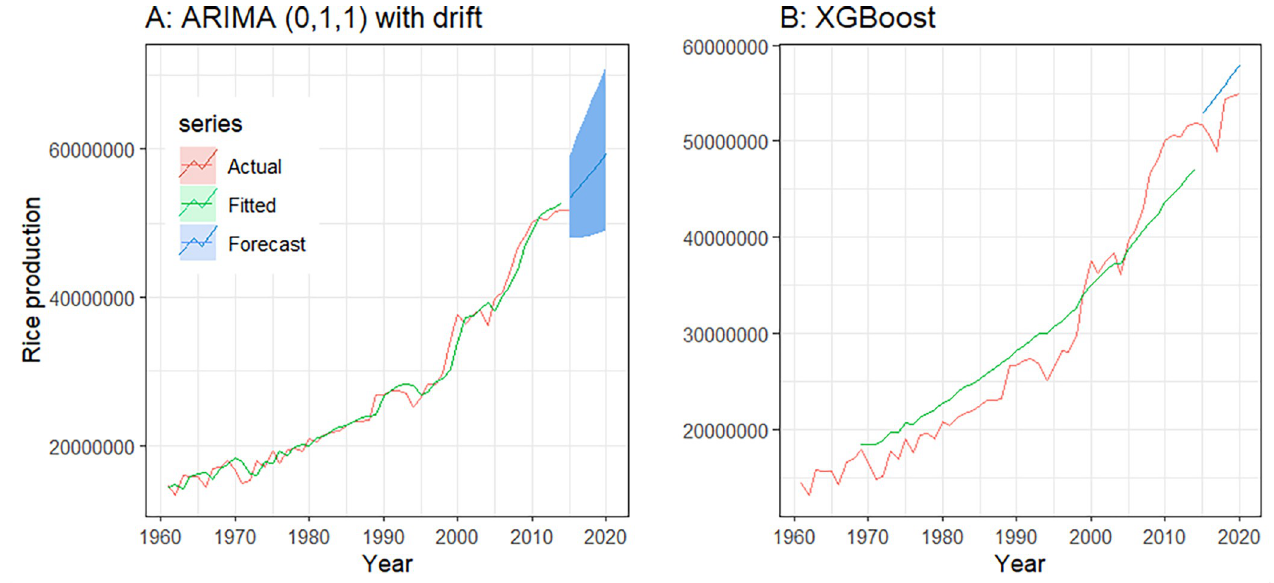
Fig 9. ARIMA and XGBoost model show the actual, fitted and forecasted data for rice production in Bangladesh. ARIMA, autoregressive integrated moving average; XGBoost, eXtreme Gradient Boosting.